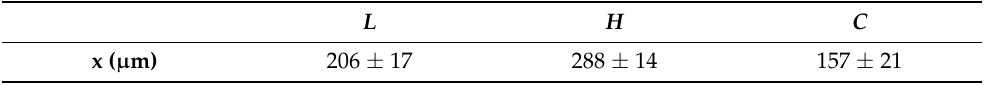
Table 4. Characteristic lengths of the saw-toothed chip 25 teeth for h = 280 µ m